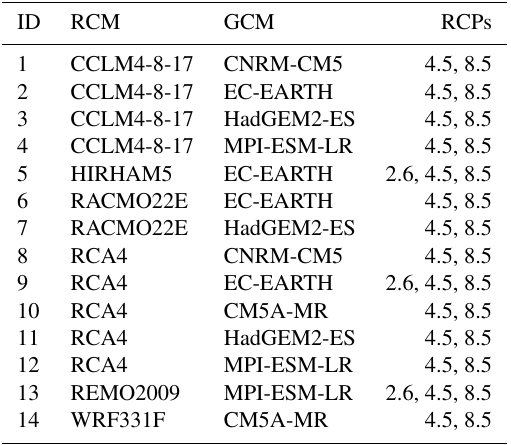
Table 2. EURO-CORDEX scenario simulations used in this